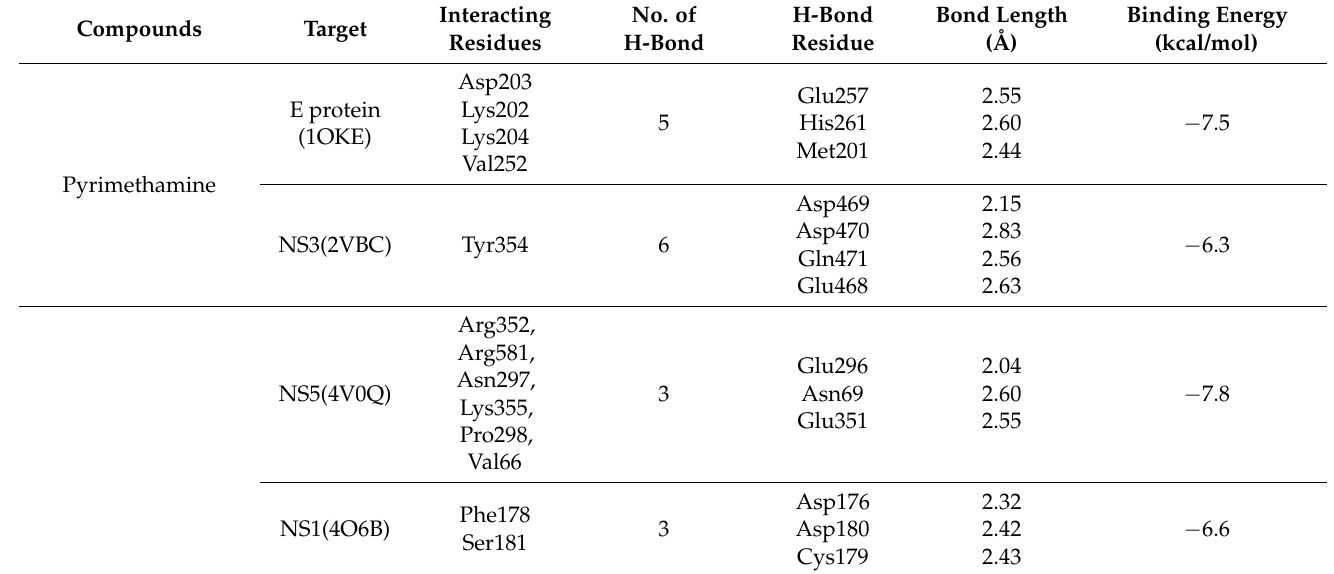
Table 6. Results for the docking of pyrimethamine with all four dengue viral protein target proteins. Interacting No. of H-Bond Bond Length Binding Energy Compounds Target Residues H-Bond Residue (Å) (kcal/mol) E protein Pyrimethamine